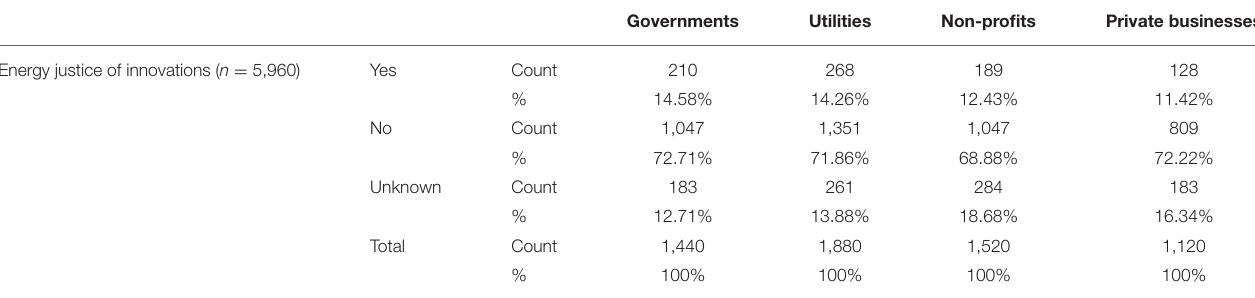
TABLE 8 | Combined frequencies across provider types.